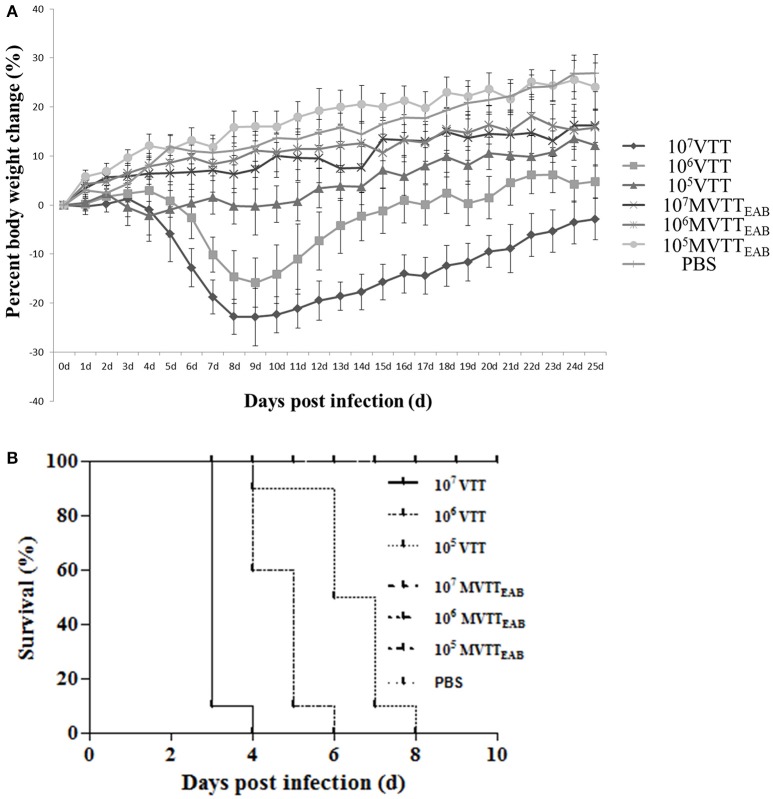
Virulence of VVTT and MVTTEAB in mice after intranasal and intracranial infection. (A) Body weight changes were monitored in mice that were intranasally infected with 105, 106, or 107 PFU of MVTTEAB or VVTT (as a positive control) or PBS (as a negative control). Error bars indicate the standard error of the mean, and differences between groups were determined by two-way repeated measures analysis of variance. Mice inoculated with VVTT showed significant signs of illness, and a clear positive correlation was found between the viral dose and weight loss (P < 0.05). No distinct weight changes or signs of illness were observed in the animals inoculated with MVTTEAB or PBS. (B) Mice were inoculated intracranially with 105, 106, or 107 PFU of MVTTEAB or VVTT (PBS in the negative control group), and the survival rates were observed for 14 days. All the mice inoculated with MVTTEAB survived, while all the mice infected with VVTT died.